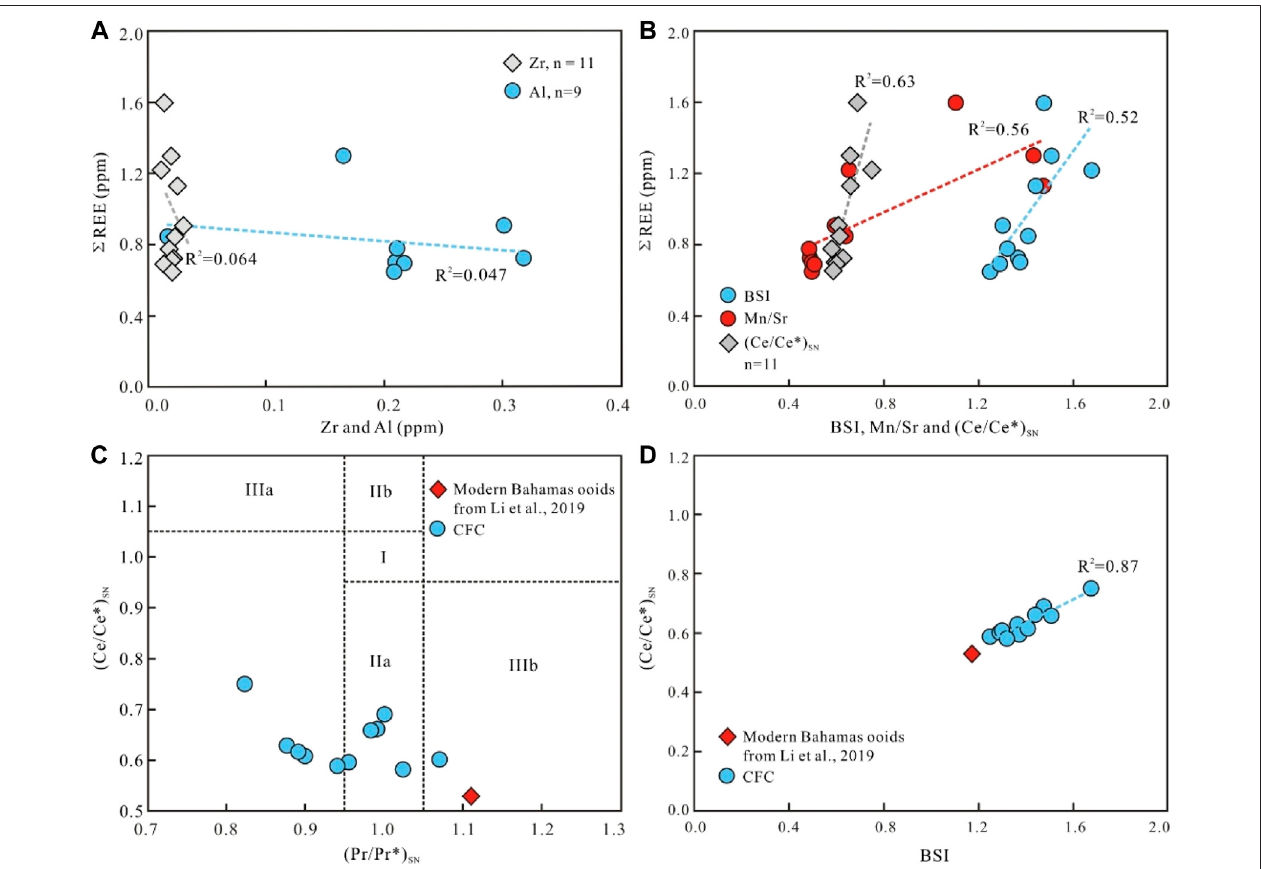
FIGURE10 | (A) Plots of Al and Zr content versus total REE concentration in the studied CFC samples. (B) Cross plot among Σ REE and BSI, Mn/Sr, and Ce anomaly,showingallpositivecorrelation. (C) DiagramdiscriminatingbetweenLaandCeanomalies(afterBauandAlexander,2009).TheCFCsamplesarecharacterized by a signi fi cant positive La anomaly. (D) Cross plot between BSI values (MREE enrichment) and Ce anomalies showing strong positive correlation.